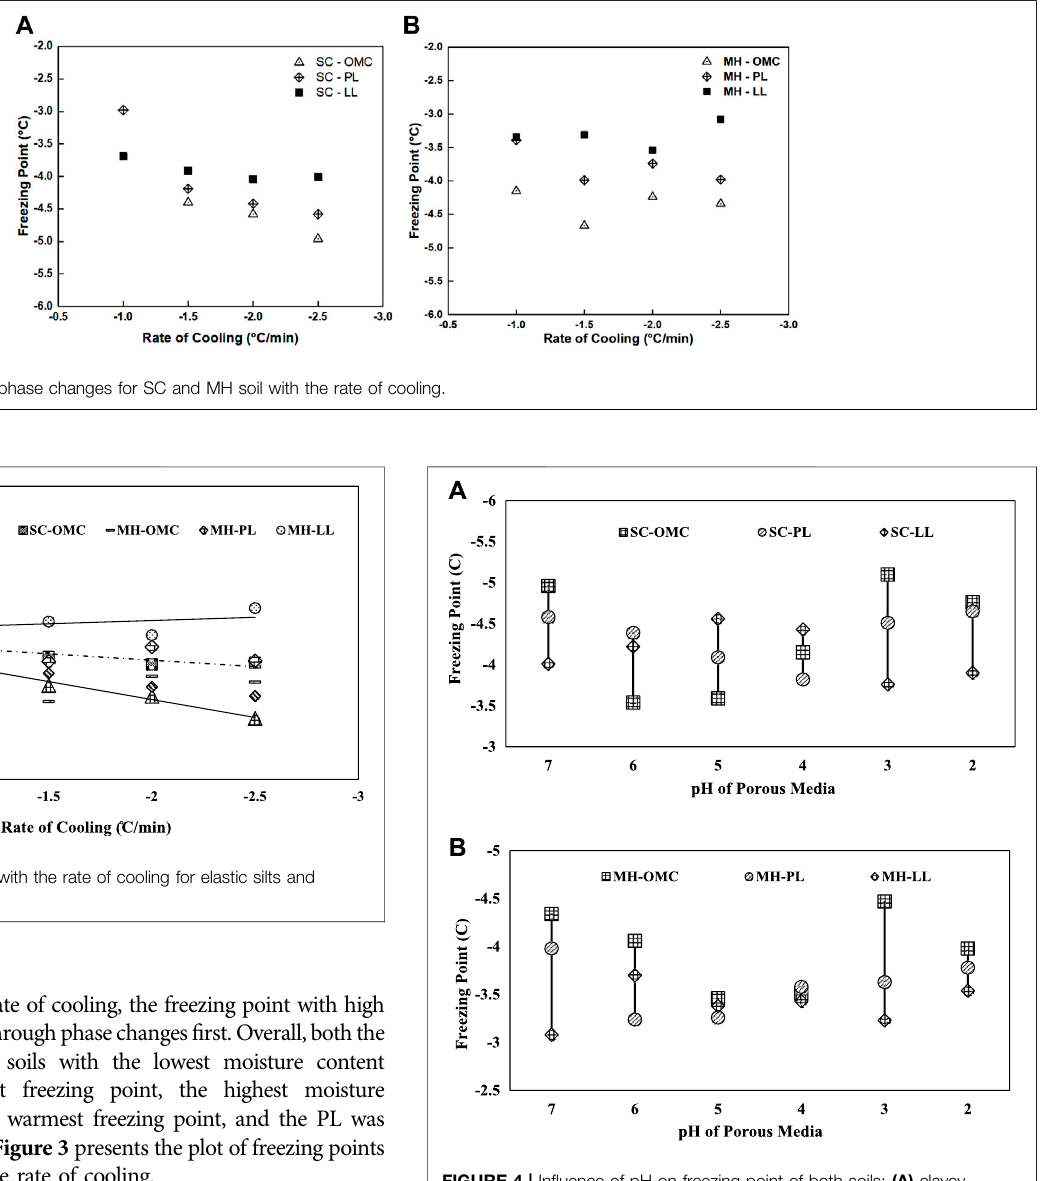
FIGURE 4 | In fl uence of pH on freezing point of both soils: (A) clayey sand; (B) elastic